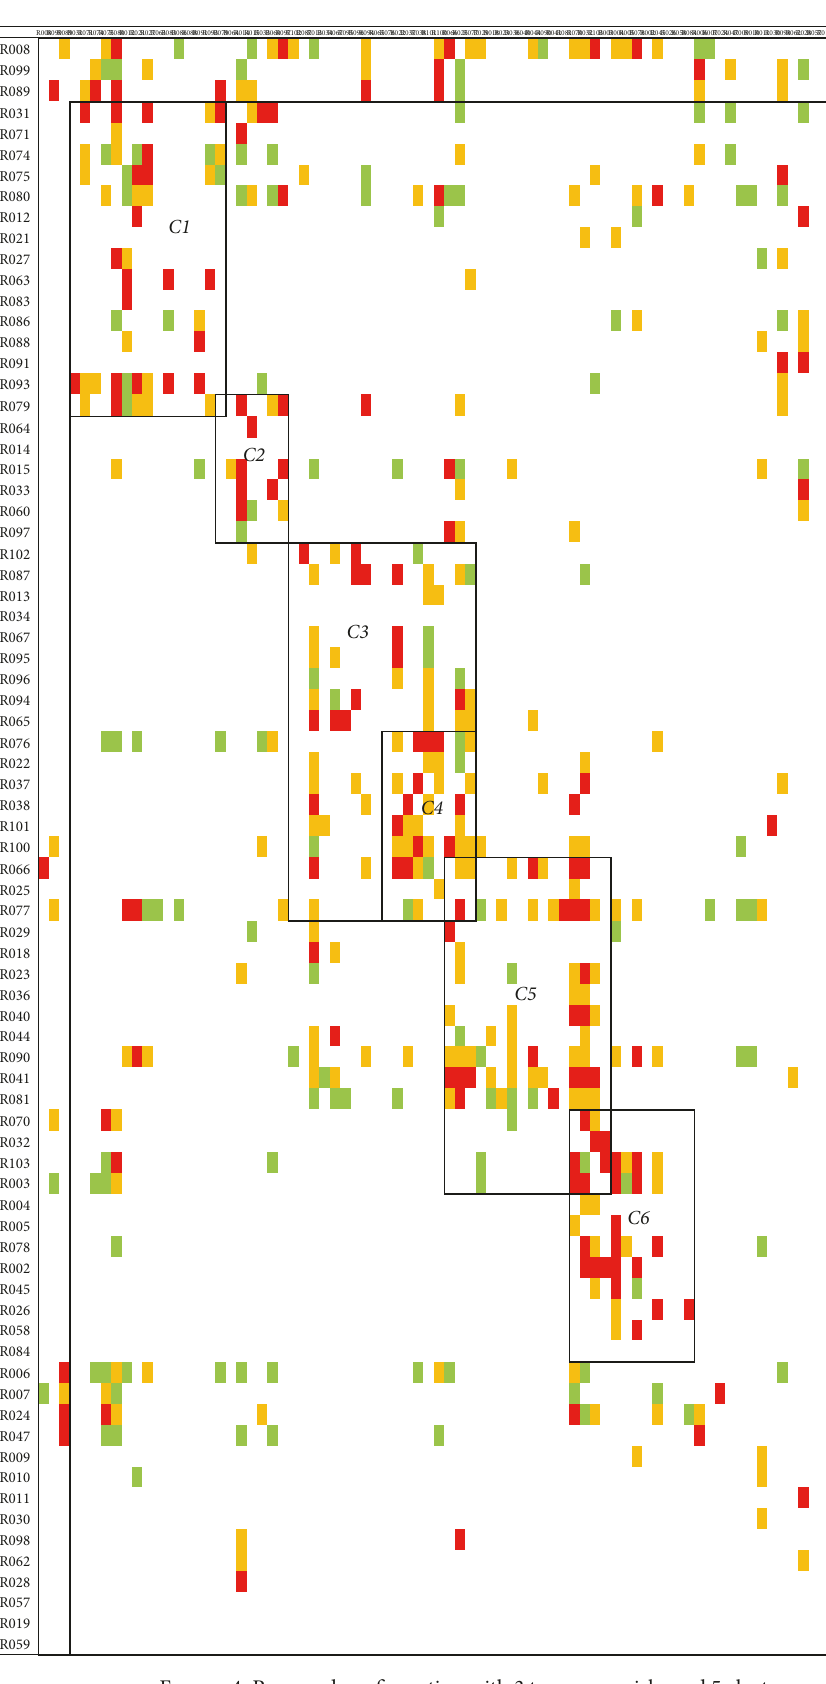
Figure 4: Proposed configuration with 3 transverse risks and 5